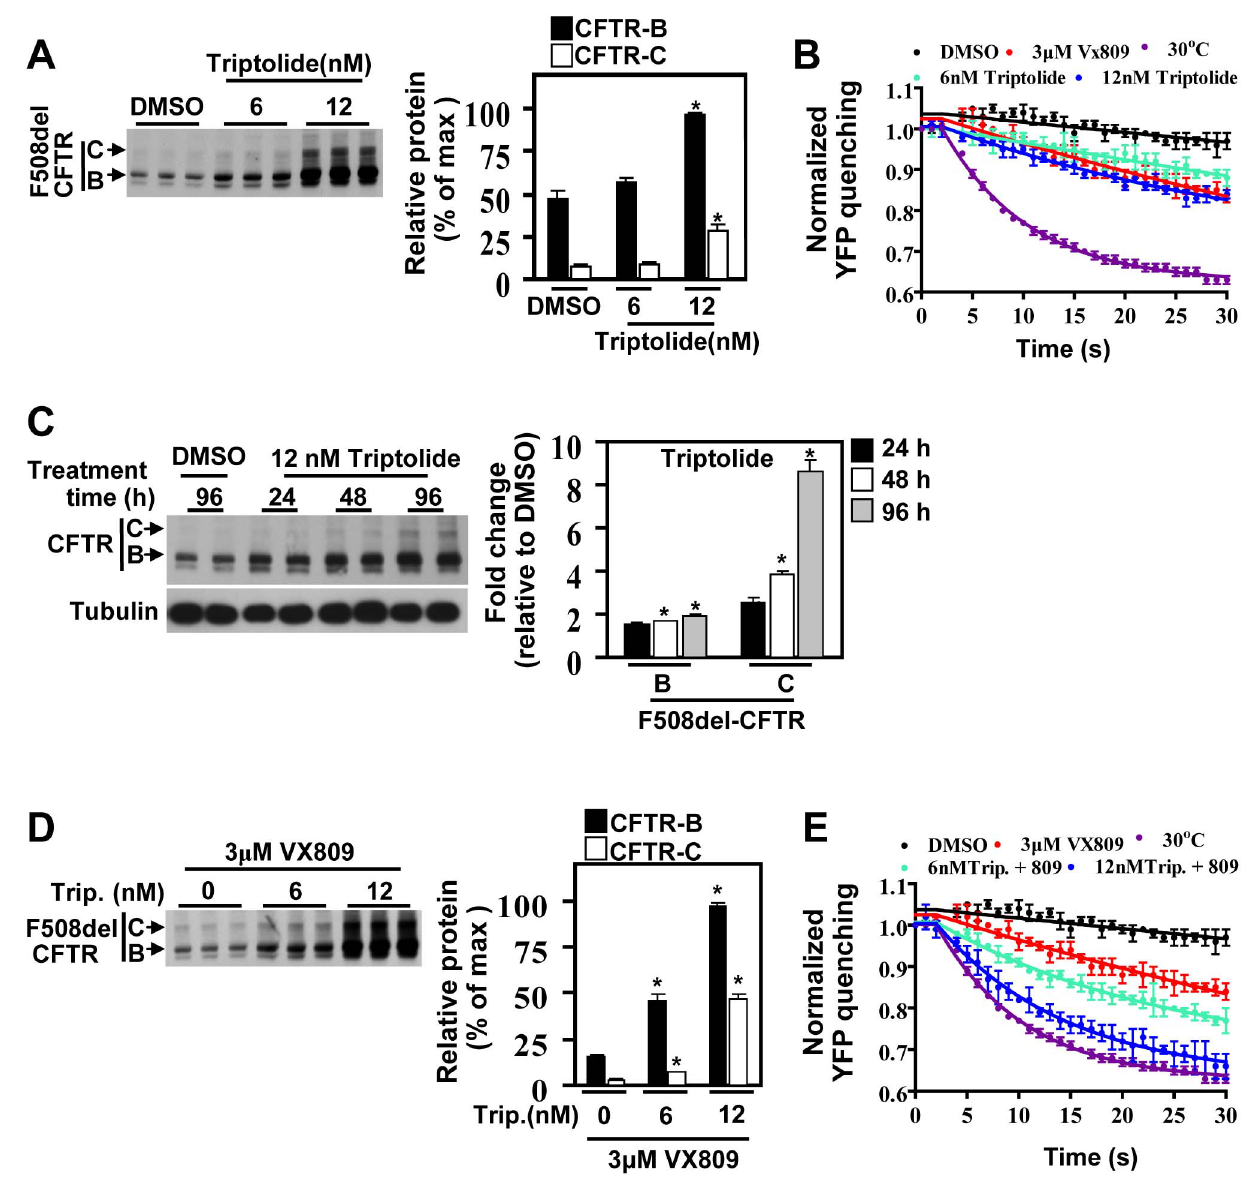
Figure 6. Chemical inhibition of HSF1 improves F508del-CFTR function. Immunoblot and quantification of CFTR following treatment of F508del-CFTR–expressing CFBE cells with increasing concentration of triptolide (Trip.) alone (A) or in combination with the CF corrector VX809 (D). Results are expressed as percentage of maximum signal of CFTR band-B (set at 100%), and shown as mean 6 SEM, n $ 3; * represents p , 0.05 relative to DMSO. (C) Immunoblot and quantitative analysis of CFTR following a daily chronic dosing regimen (96 h) of 12 nM triptolide in F508del-CFTR expressing cells. Results are expressed as fold change relative to DMSO, and shown as mean 6 SD, n =2; * represents p , 0.05 relative to DMSO. YFP- quenching curves of F508del-CFTR expressing CFBE-YFP cells treated with the indicated compounds for 24 h alone (B) or in combination (E) (mean 6 SD, n $ 3). All results were repeated at least once. The underlying data used to make (A–E) in this figure can be found in the supplementary file Data